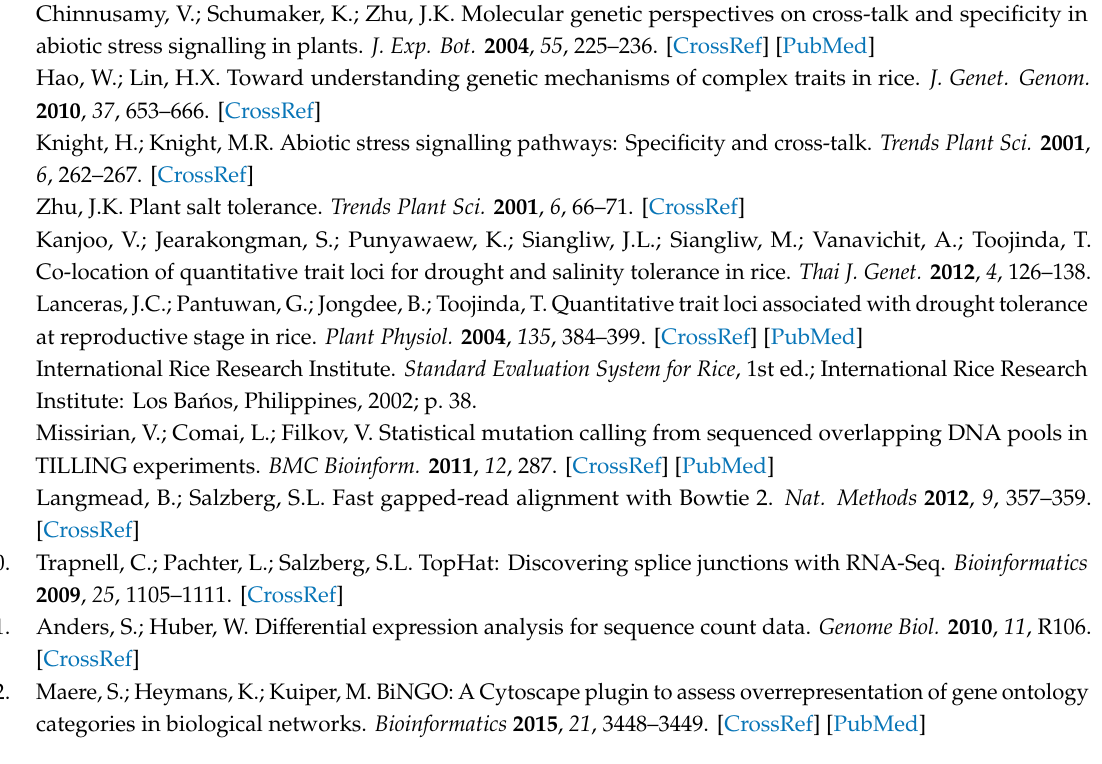
Figure S1: Leaf water potential of the first fully expanded leaves of four CSSLs, parental lines ‘(KDML105’ and DH212), and salt-tolerant (‘Pokkali’) and salt-susceptible (IR29) lines grown under normal conditions (A), and after 75 mM NaCl (B), and 150 mM NaCl (C) salt treatment for 0–12 days, Table S1: Details of the loci of di ff erentially expressed genes detected by analysis of the ‘KDML105’ transcriptomes under normal and salt stress conditions, Table S2: Details of the loci of di ff erentially expressed genes detected by analysis of the CSSL18 transcriptomes under normal and salt stress conditions, Table S3: Description and GO annotations of the di ff erentially expressed genes in both ‘KDML105’ and CSSL18 under salt stress, Table S4: Details of the genes that were di ff erentially expressed only in ‘KDML105’ under salt stress, Table S5: Details of the genes that were di ff erentially expressed only in CSSL18 under salt stress, Table S6: Regulatory genes enriched from MapMan analysis compared between ‘KDML105’ and CSSL18 after two days of salt